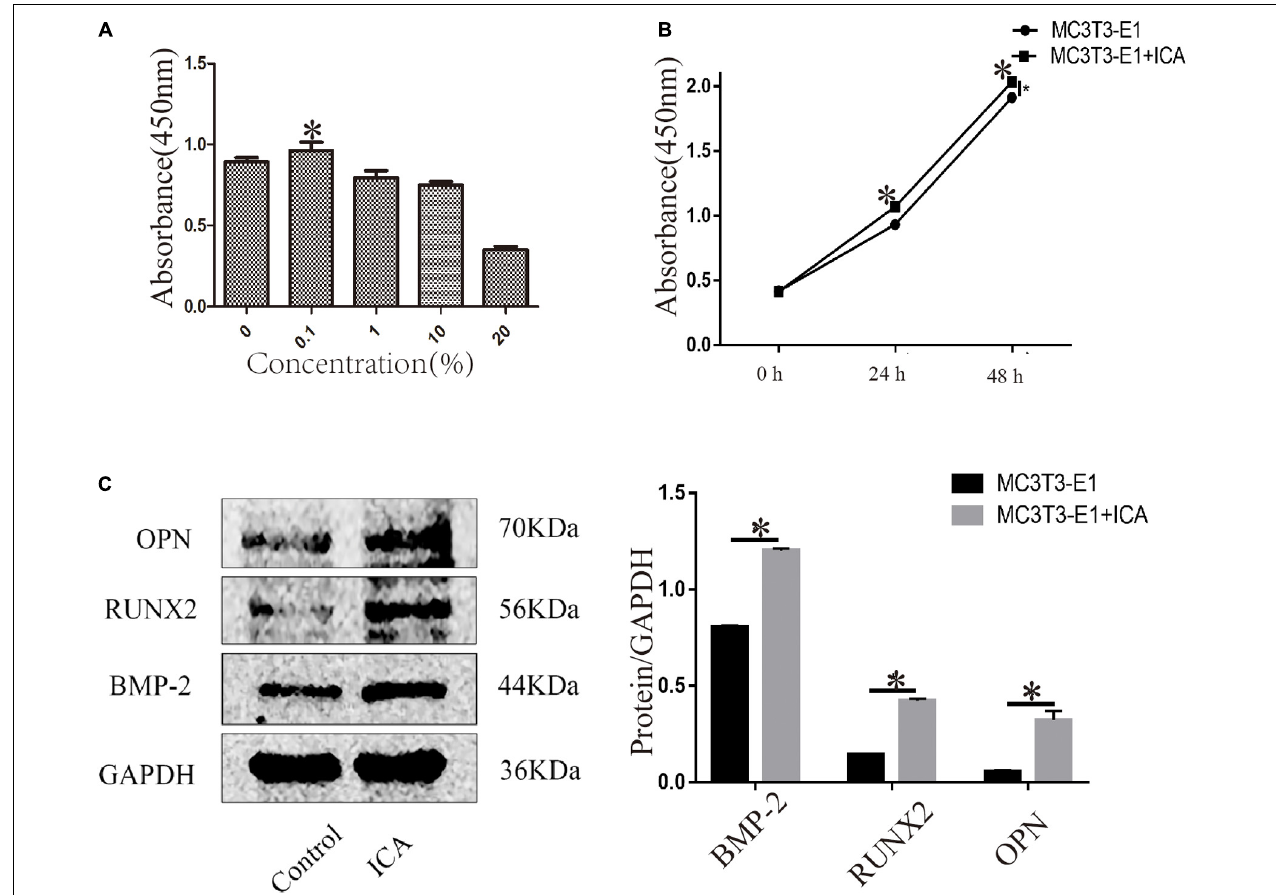
FIGURE 3 | Effects of ICA on osteoblast proliferation. (A) ICA (0.1 µ g/mL) promoted osteoblast proliferation; (B) Time dependence of the effect of ICA on osteoblast proliferation activity; and (C) Increased protein expression of BMP-2, RUNX2, and OPN after ICA was applied to MC3T3-E1 cells. * P -value < 0.05 ( n = 4).